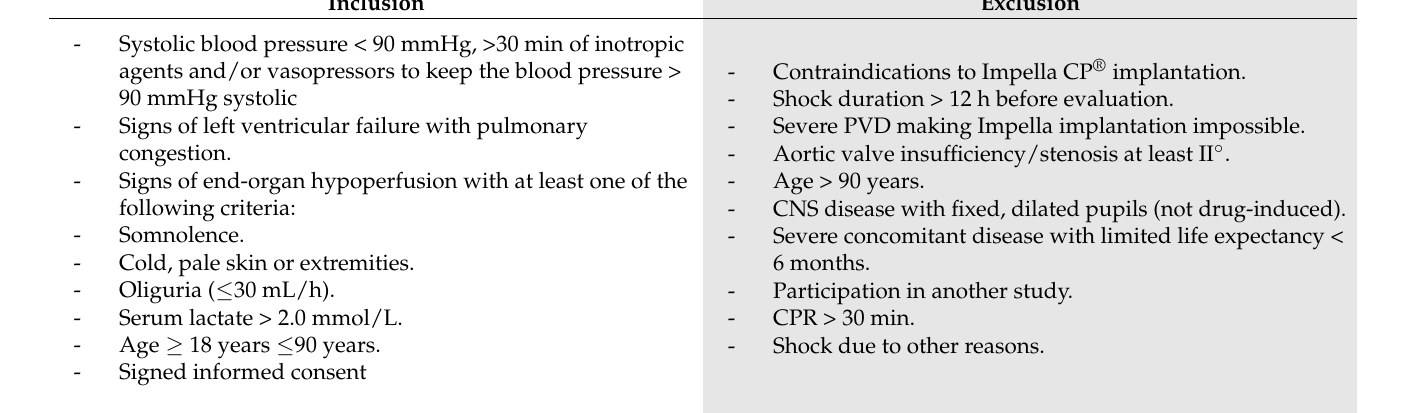
Table 1. Inclusion and exclusion criteria of the JenaMACS